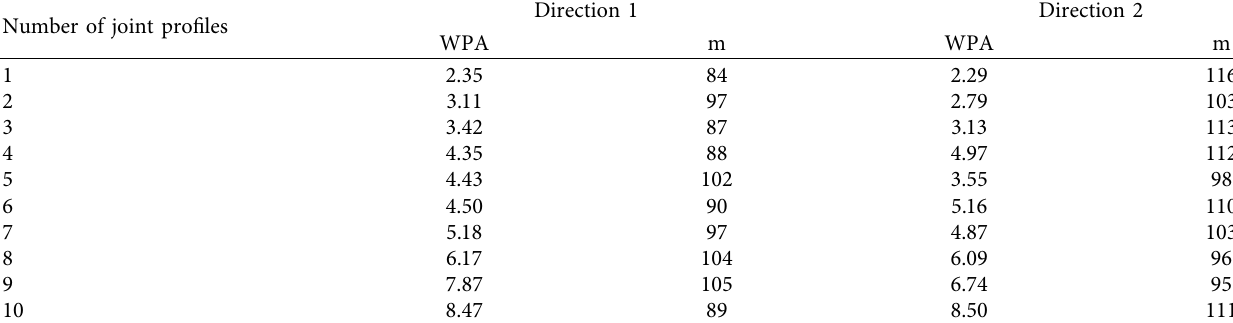
Table 2: The WPA values of 10 joint profiles in different directions (SI � 0.5mm).